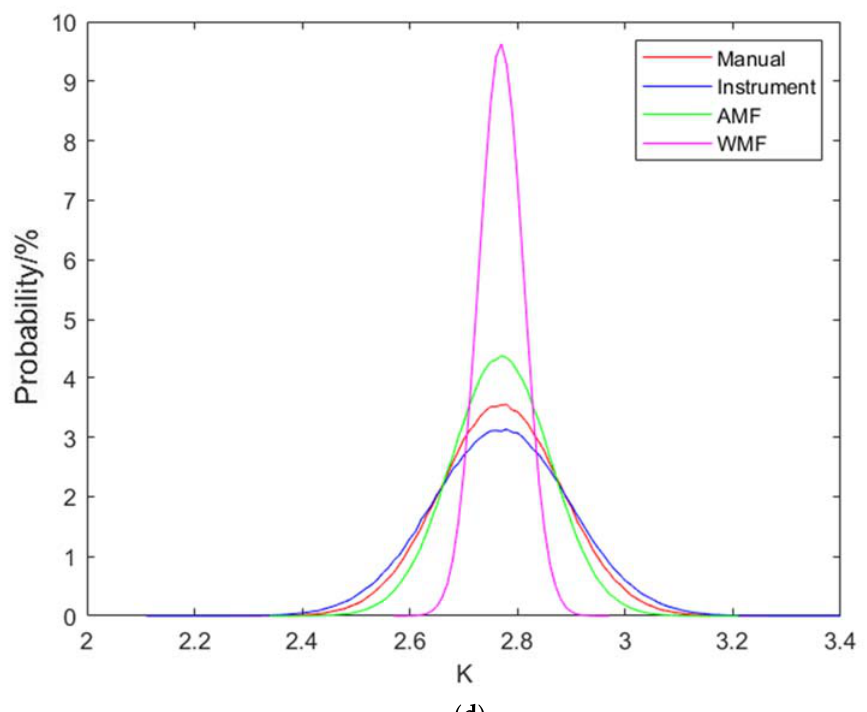
Figure 8. Results of fusion K of ( a ) K1, ( b ) K1.5, ( c ) K2 and ( d ) K2.5 probes.